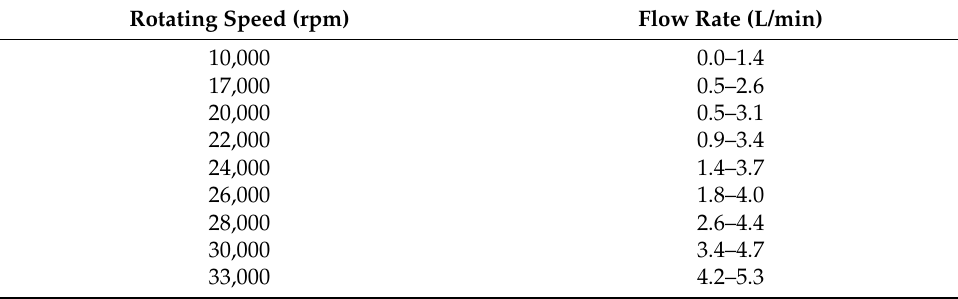
Table 2. The relationship between the rotating speed and flow rate of Impella 5.0